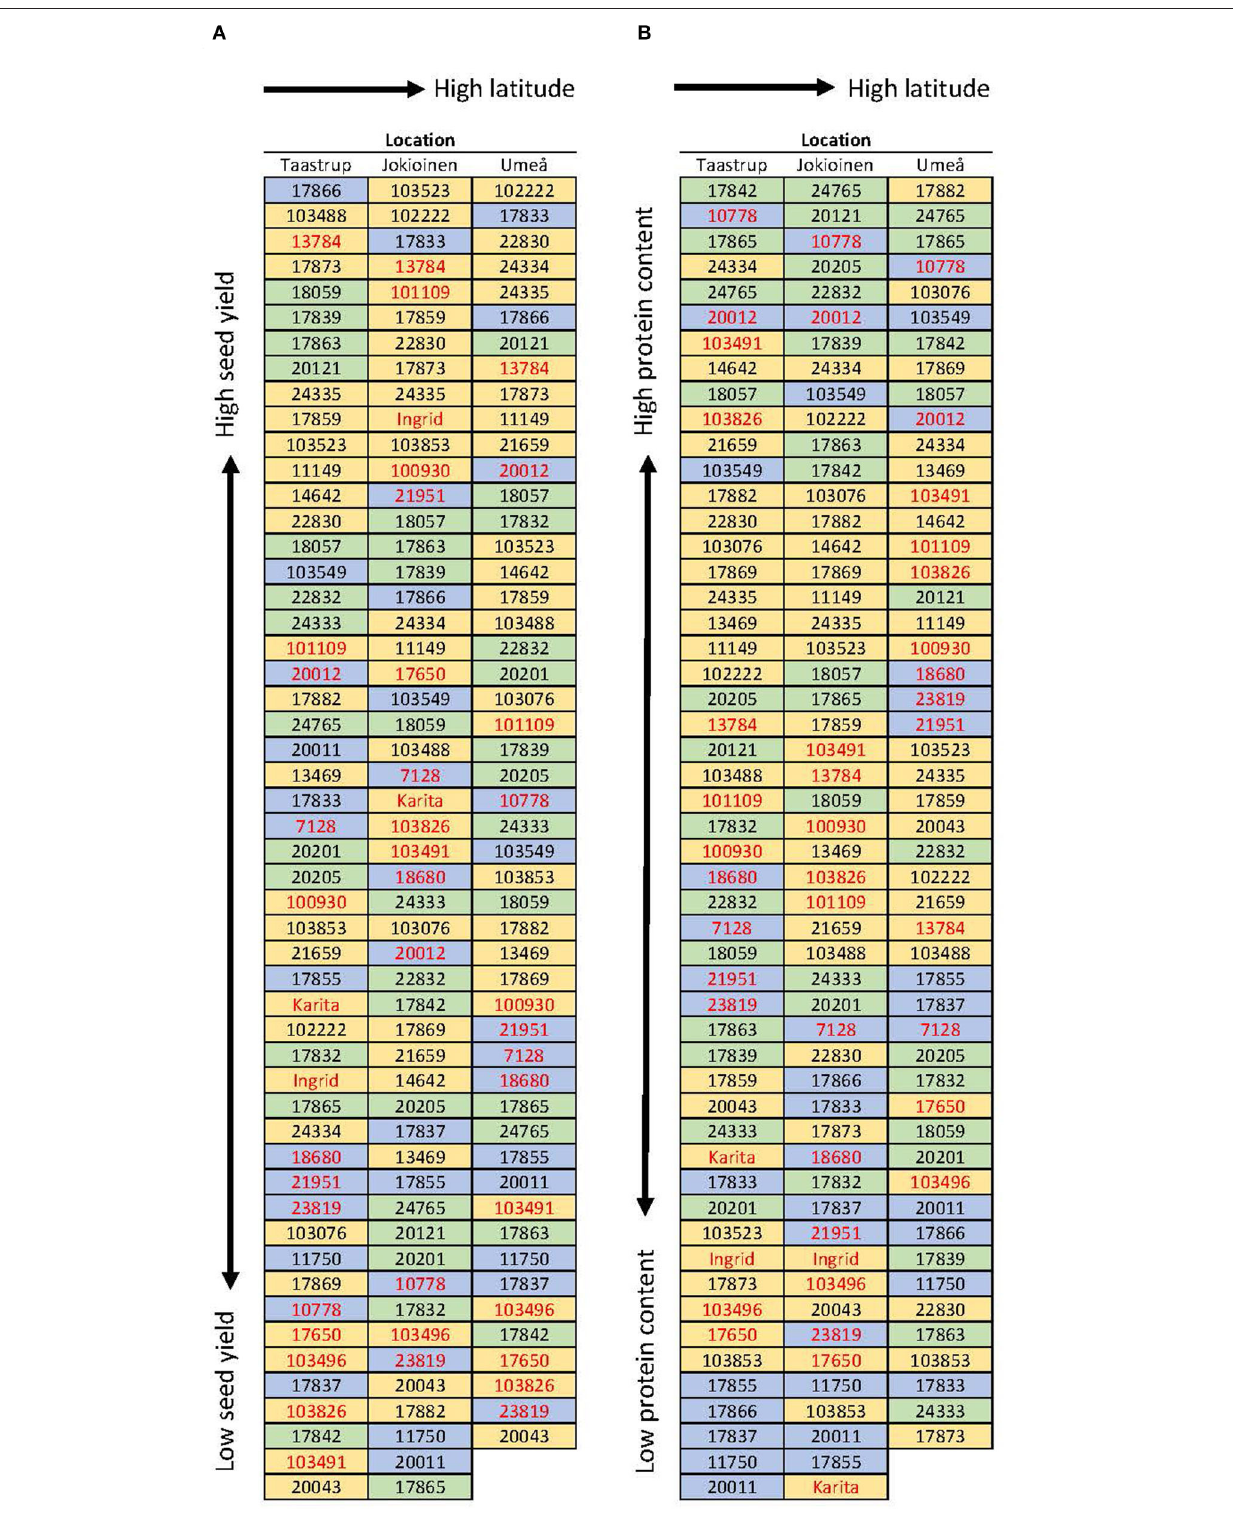
Frontiers in Plant Science |